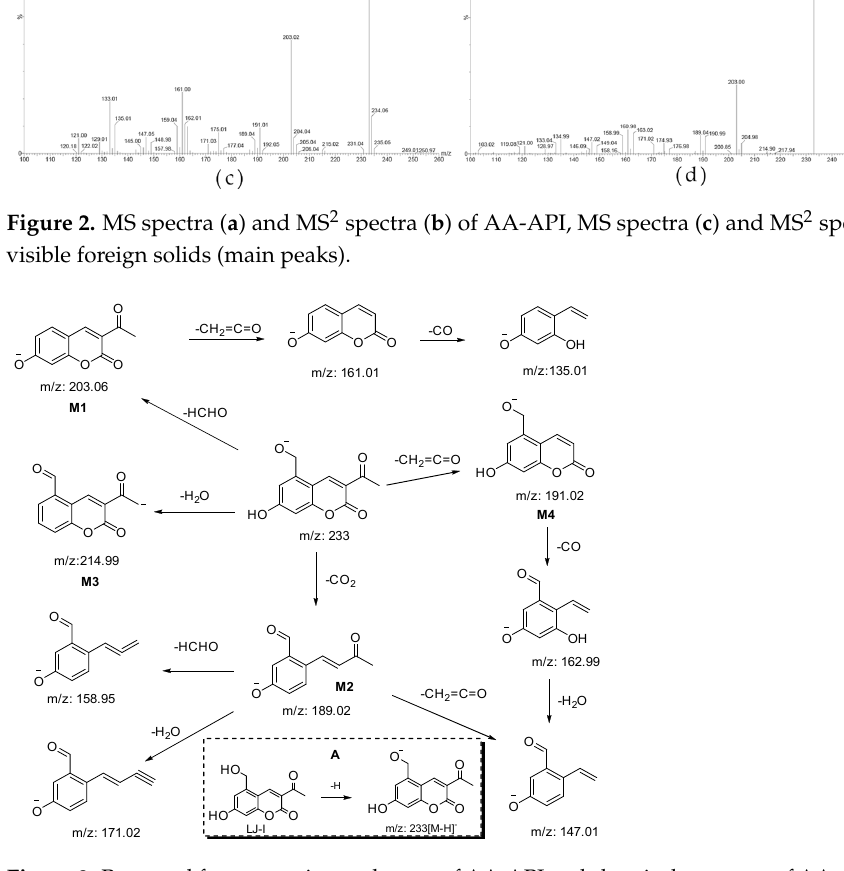
Figure 3. Proposed fragmentation pathways of AA-API and chemical structure of AA-API in negative ion mode as [M-H] −